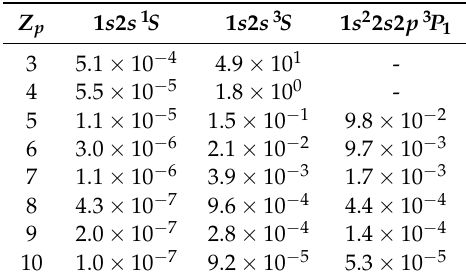
Table 1. Indicative theoretical lifetimes (in s) of the metastable He-like 1 s 2 s 1 S , 1 s 2 s 3 S (from Refs. [66,67]) and Be-like 1 s 2 2 s 2 p 3 P 1 states (from Refs. [68,69]) for 3 ≤ Z p ≤ 10 .